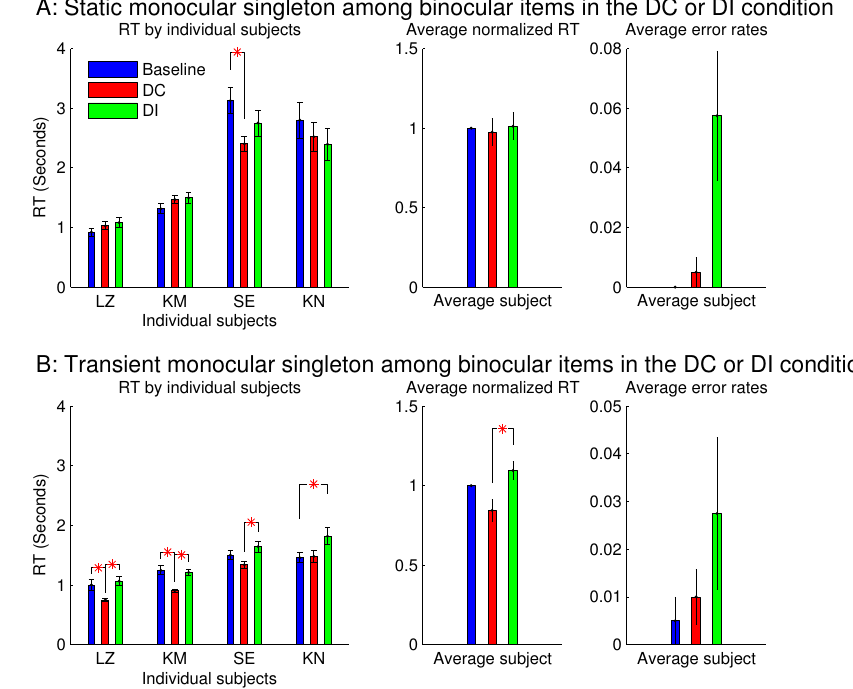
Figure 8. A transient ocularity contrast also attracted attention; and the transientness helped to reveal the attentional attraction by a monocular singleton in a background of binocular items. ( A ) are plots from Figure 7B and ( B ) are plots from another session that differed from the session in (A) by making the ocularity contrast transient. Specifically, the monocularity of the singleton was present only in the initial 0.15 s of the search stimulus, and after this initial period, this search item became binocular (while C L + C R was unchanged) like all the binocular items in the search